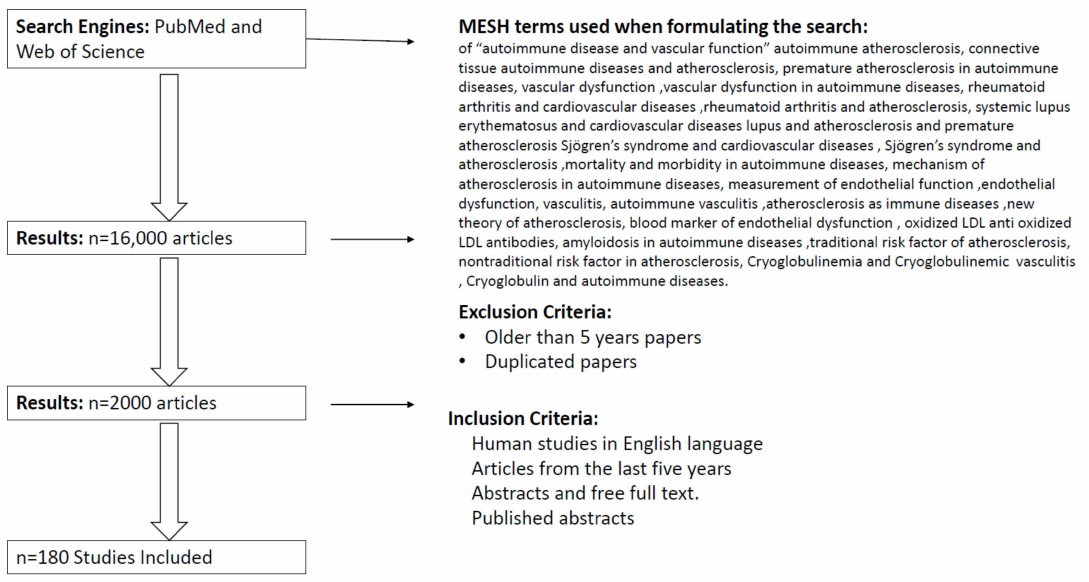
Figure 1. Overview of studies